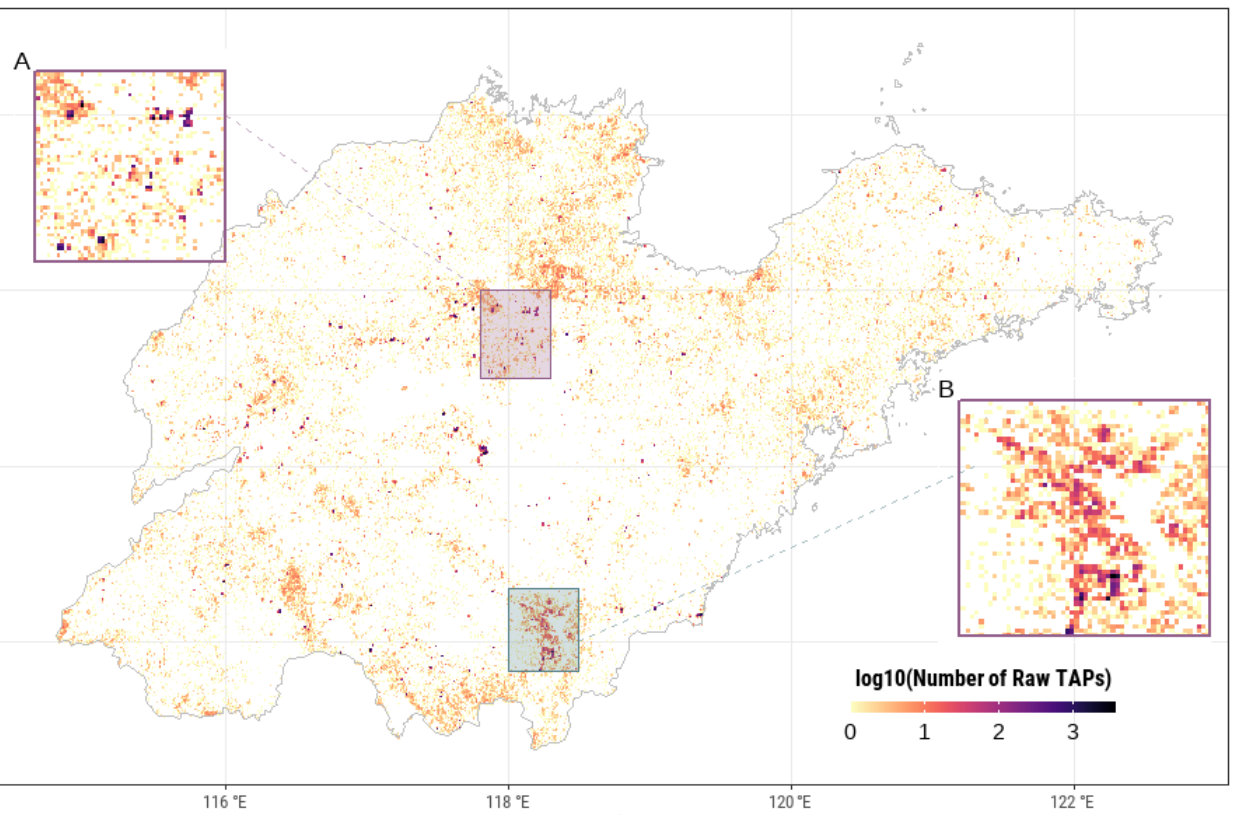
Figure 1. Spatial location of Shandong Province ( A ) in China ( B ). The background map represents